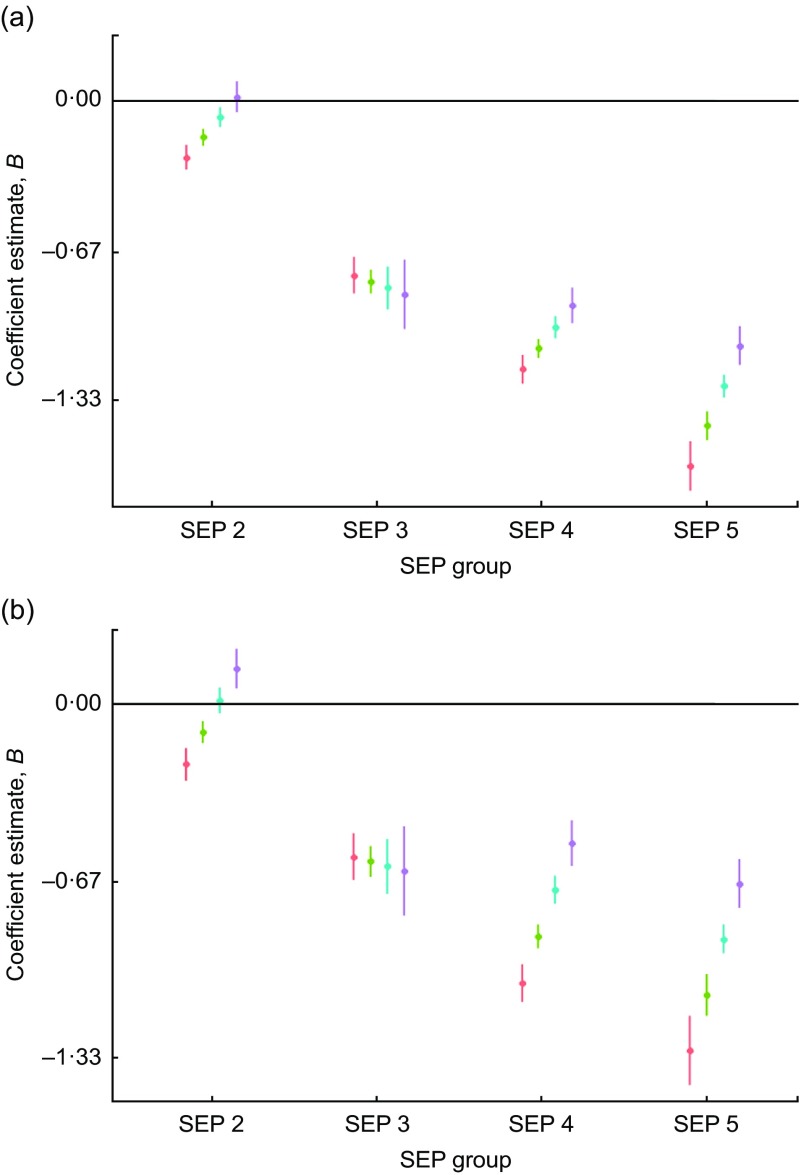
Regression estimates of (a) male and (b) female weight size Z-scores (dots) with 95 % CI (whiskers) across socio-economic position (SEP) groups (2–5), with SEP 1 as reference group (horizontal line at 0), by decade of birth centred on 1960 (), 1970 (), 1980 () and 1990 (), for children and adolescents (n 40 484) aged 3–19 years of Ladino and Maya ancestry born during 1955–1993 in Guatemala (n
observations 157 067). The plots were created using R packages ggplot2, broom, jtools, dotwhisker and dplyr (see the online supplementary material for references)